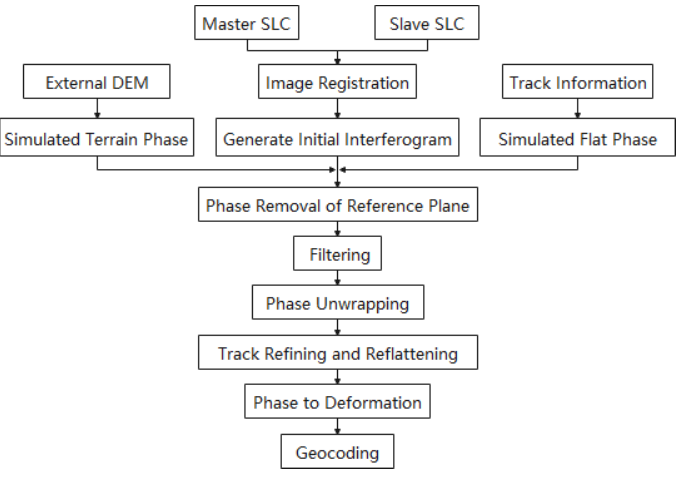
Figure 2. DInSAR processing workflow.